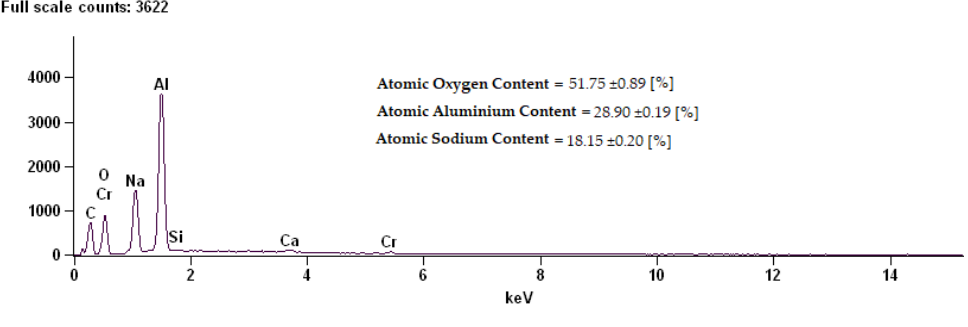
Figure 5. SEM micrographs with chemical analysis field marked: ( a ) Sample 02D, ( b ) Sample 02E, ( c ) Sample